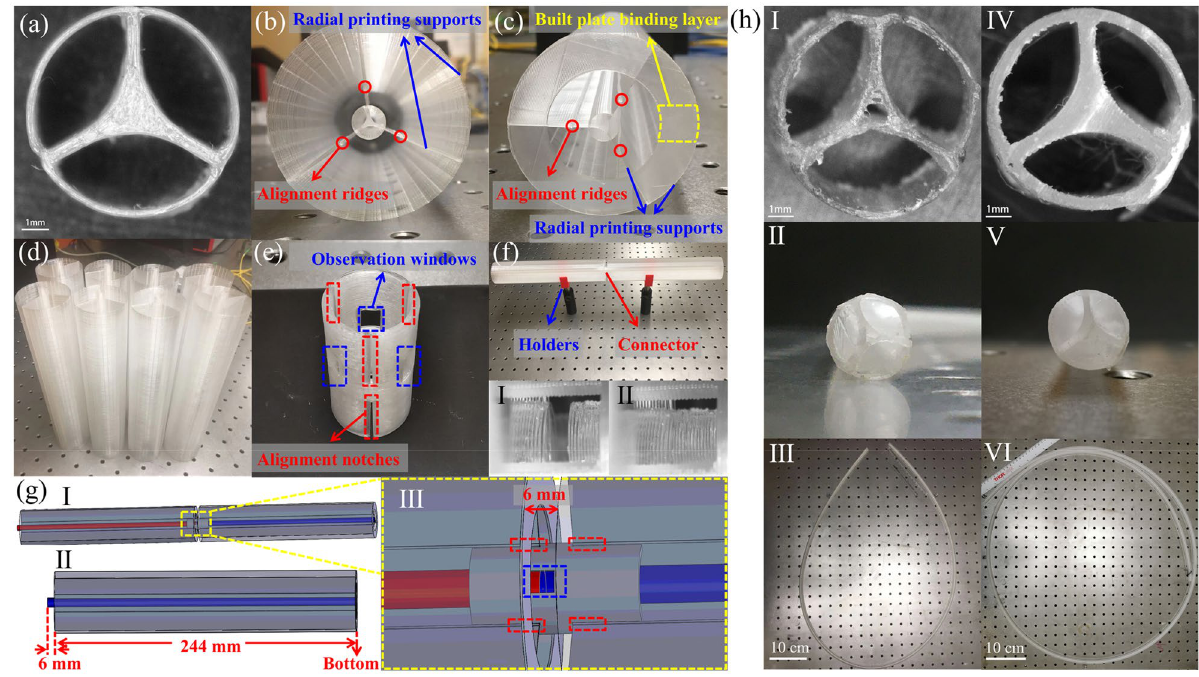
Figure 2. ( a ) Cross-section of the FDM printed fiber with printing supports removed. ( b ) As printed fiber section (top view) with radial printing supports and inter-section alignment ridges. ( c ) As printed fiber section (bottom view) with radial printing supports, a built plate binding layer, and alignment ridges. ( d ) Eight of the 25 cm-long fiber sections are to be combined into a 2 m-long fiber. ( e ) The connector and its 3D schematics. ( f ) Two fiber sections are connected using one connector and two holders. Insets: I (disconnected) and II (connected)—microscope view of the connection between two fiber sections. ( g ) 3D Schematics of (I) the interconnection between two fiber sections and (II) one single fiber section. (III) An enlarged schematic of the connector region featuring alignment elements (red dotted regions) and observation windows (blue dotted region). ( h ) Two several meter-long fibers were printed using an infinity FDM printer. (I) (IV) Microscopy images of the fiber cross-sections, (II)(V) side views, and (III)(VI) top views of the continuous 1.4 m-long (defect core) and 2.5 m-long (solid core) fiber